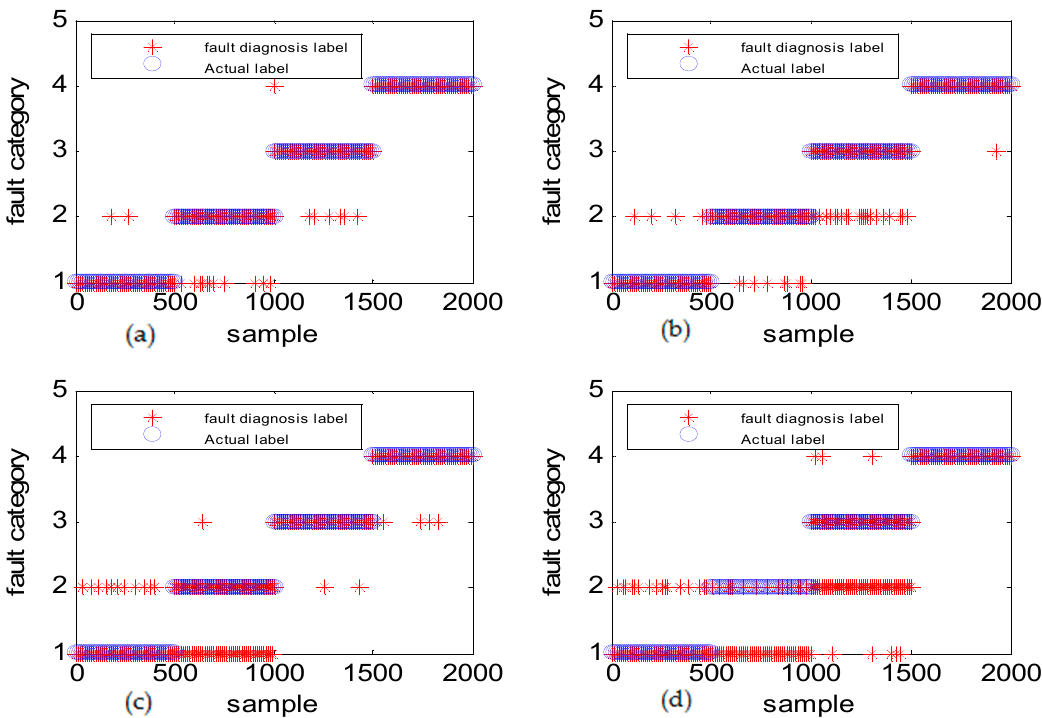
Figure 18. Case study for diagnosis of different types of fault with the same size of 0.007 inches: ( a ) DGFFDNN, ( b ) DNN, ( c ) DGFFBP, and ( d ) BP.